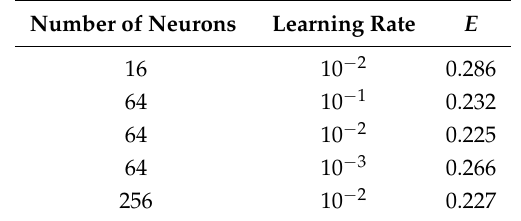
Table 1. The influence of the number of neurons and learning rate on artificial neural network (ANN)-computed surrogate models’ prediction accuracy. The O-DLB-4-3 case is used for the prediction accuracy